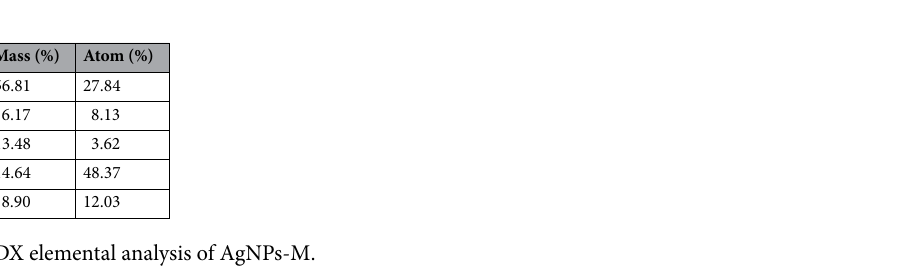
Figure 5. ( A – D ) SEM images of AgNPs-M at different magnifications: ( A ) ×100, ( B ) ×1000, ( C ) ×50,000, ( D ) ×100,000, ( E ) a histogram with the size distribution of AgNPs-M, and ( F ) EDX images of AgNPs-M.